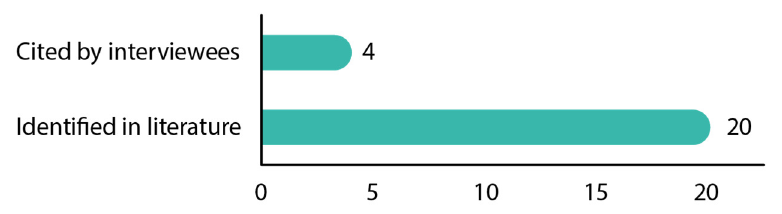
Figure 3. Methods or methodological guidelines cited by the interviewees in contrast to those identified in the literature.